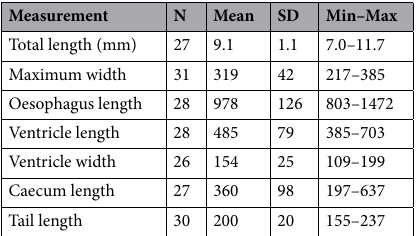
Table 4. Measurements of P. ceticola L3 from seven Macaronesian meso- and bathypelagic fish species. N = number of measurements, SD = Standard deviation. Measurements in µm unless